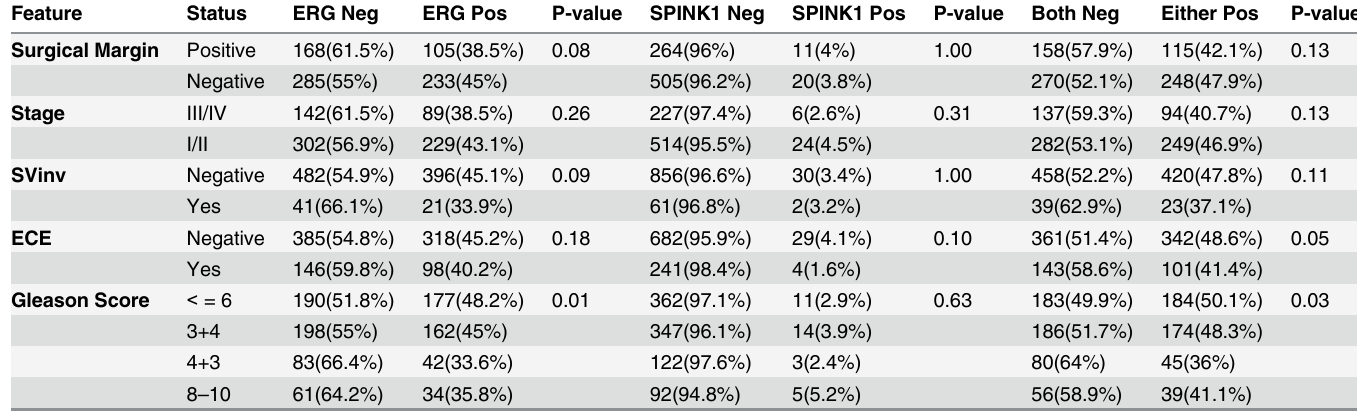
Table 2. Summary of ERG, SPINK1, and ERG/SPINK1 by pathological features.